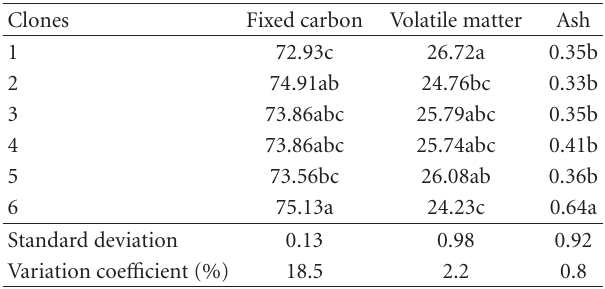
Standard deviation = 865.66 (charcoal), 374.42 (wood); variation coe ffi cient = 7.21% (charcoal), 3.52% (wood). Means followed by same letter do not di ff er at 5% probability by Tukey test. Table 3: Mean values of charcoal fixed carbon, volatile matter, and ash contents, in